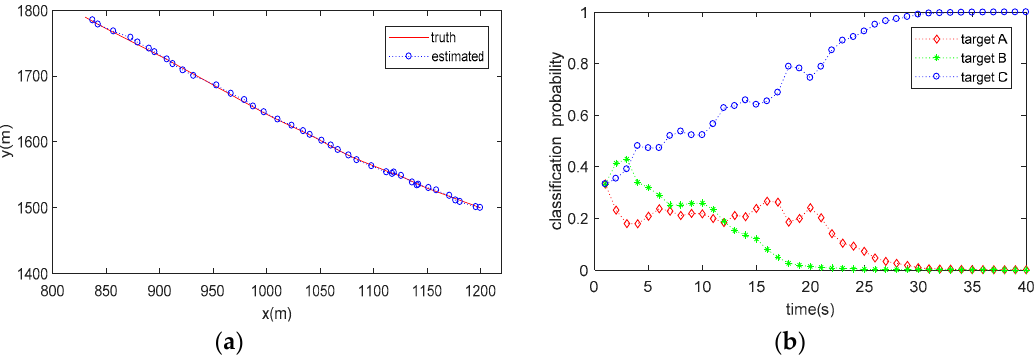
Figure 5. Result of JTC when Target Class C is present: ( a ) estimated target trajectory; ( b ) estimated target class probability.